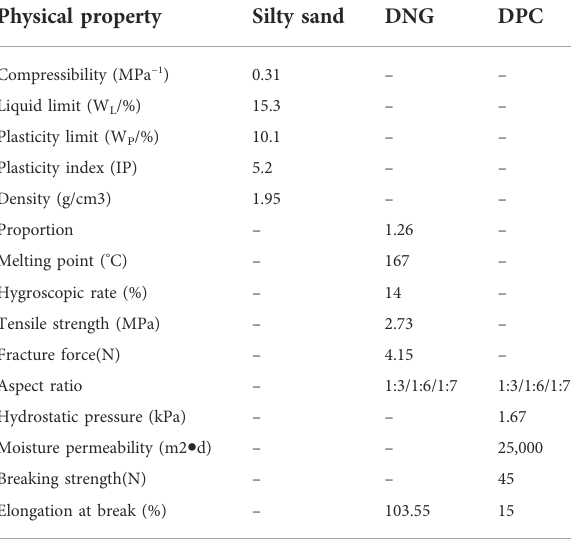
TABLE 1 Fundamental physical properties of test soil, DNG, and